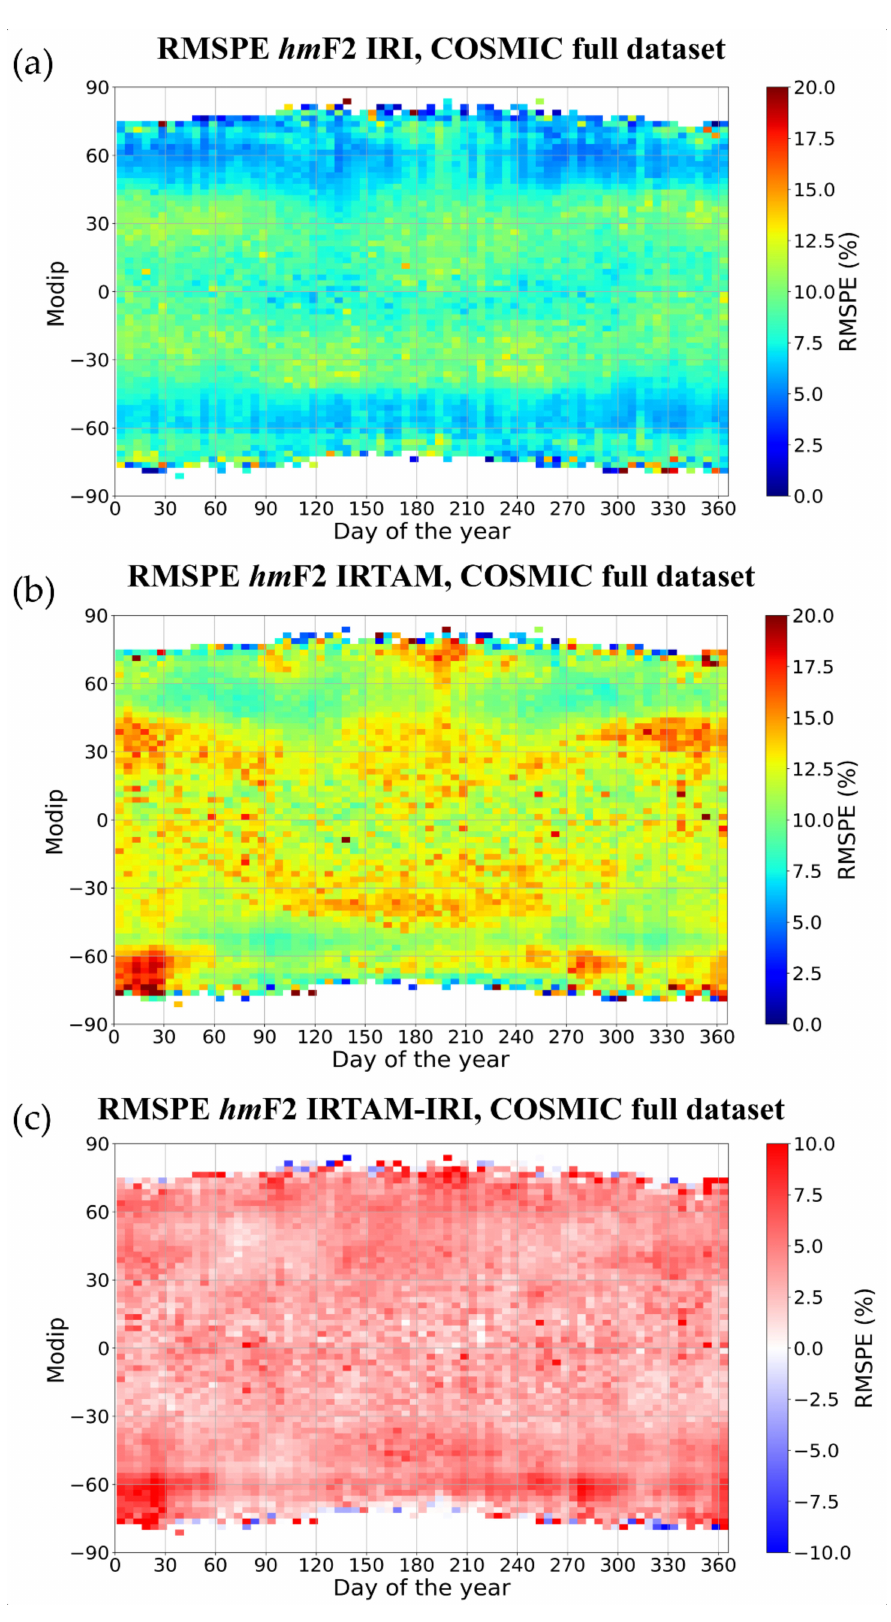
Figure 43. Same as Figure 42 but in this case data were binned as a function of the day of the year (fiveday wide bins) and modip (2.5 ◦ -wide